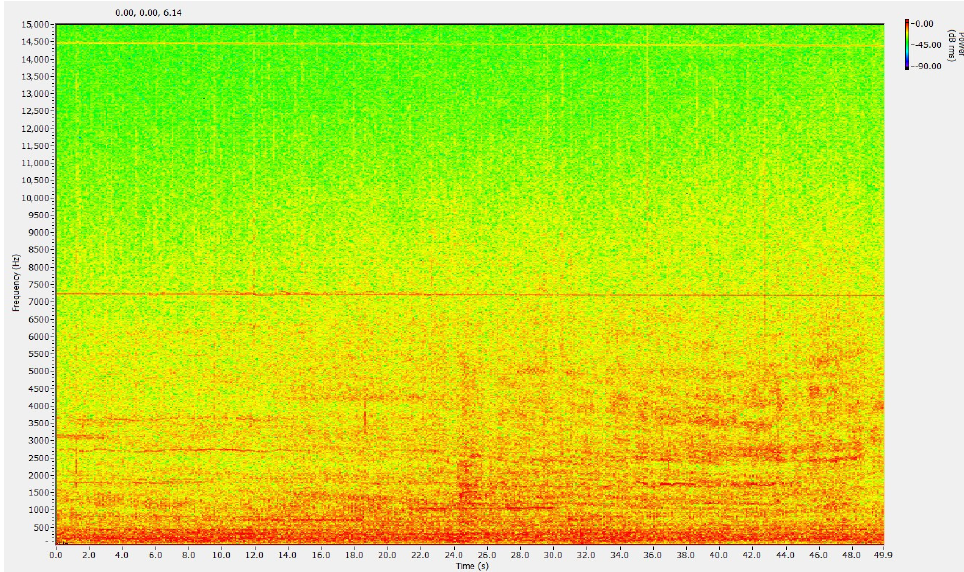
Figure 16. Signal energy chromatogram at substation 3.